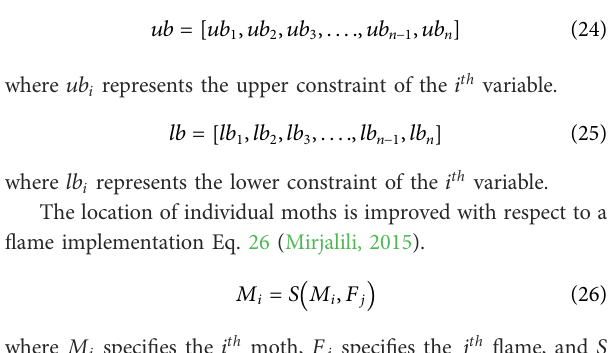
Algorithm 2: Computation of the objective function (Mirjalili, 2015).